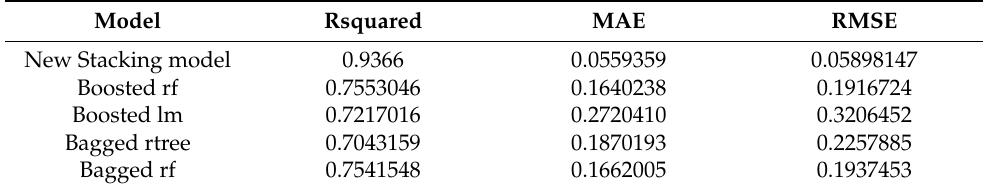
Table 8. The comparison of the best weak predictors and ensembles.